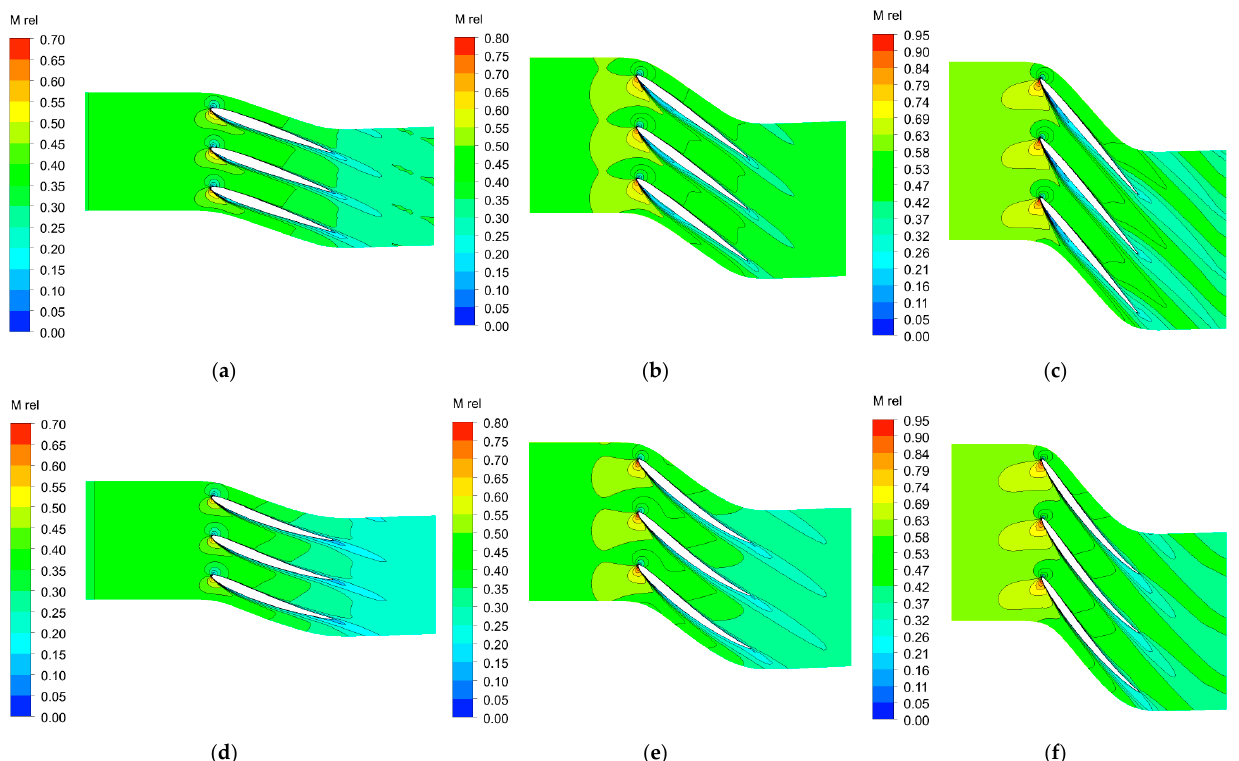
Figure 11. Mach contours at different spans: ( a ), ( b ) and ( c ) and ( d ), ( e ) and ( f ) are the blade profiles at 20%, 50% and 80% of the span layers before and after optimization, respectively.